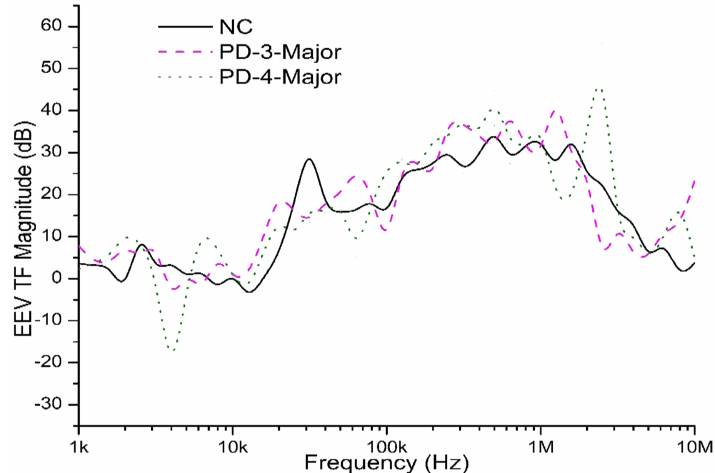
Figure 10. Comparison of EEV TF plots for the diagnosis of sources of PDs across major insulation: Normal case (vs) PD-3-major (vs)